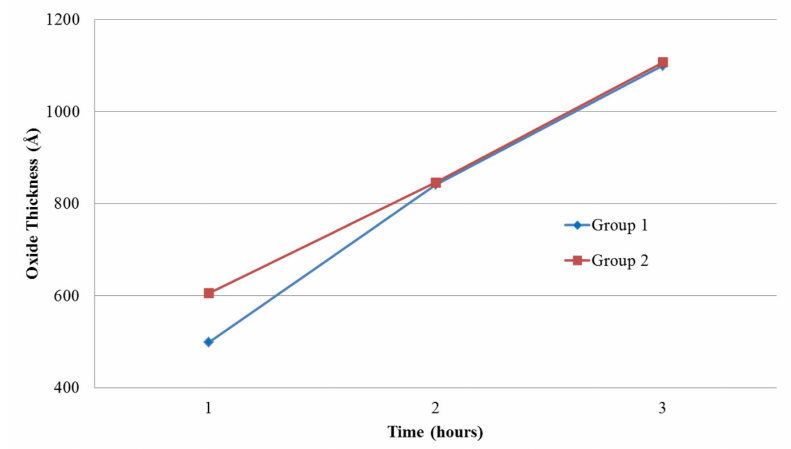
Figure 4. Plot of oxide thicknesses versus oxidation time for two data sets ( i.e. , Groups 1 and 2) of three different oxide growth times. The samples were thermally oxidated in a tube furnace at 1000 ˝ C for 1, 2 and 3 h, respectively.